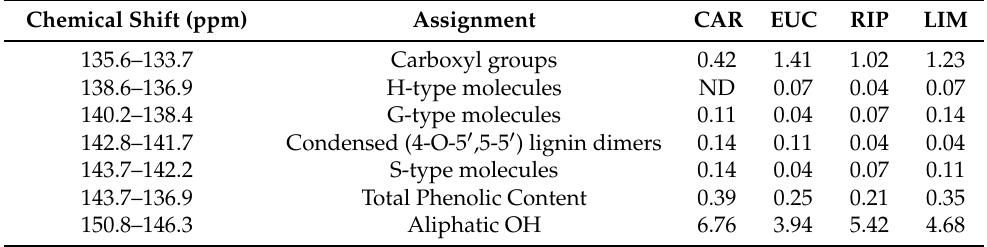
Figure 3. 31 P-NMR spectra of water-soluble lignins isolated from cardoon (CAR), eucalyptus (EUC), black poplar grown in Ripiti (RIP) and black poplar grown in Limatola (LIM) by an alkaline oxidative extractant and derivatized with 2-chloro-4,4,5,5-tetramethyldioxaphospholane. Table 2. Structural assignment, chemical shift ranges, and integrated amount (mmol·g − 1 of lignin) of main signals in 31 P-NMR spectra of lignins isolated from cardoon (CAR), eucalyptus (EUC), black poplar grown in Ripiti (RIP) and black poplar grown in Limatola (LIM) by alkaline oxidative extraction.